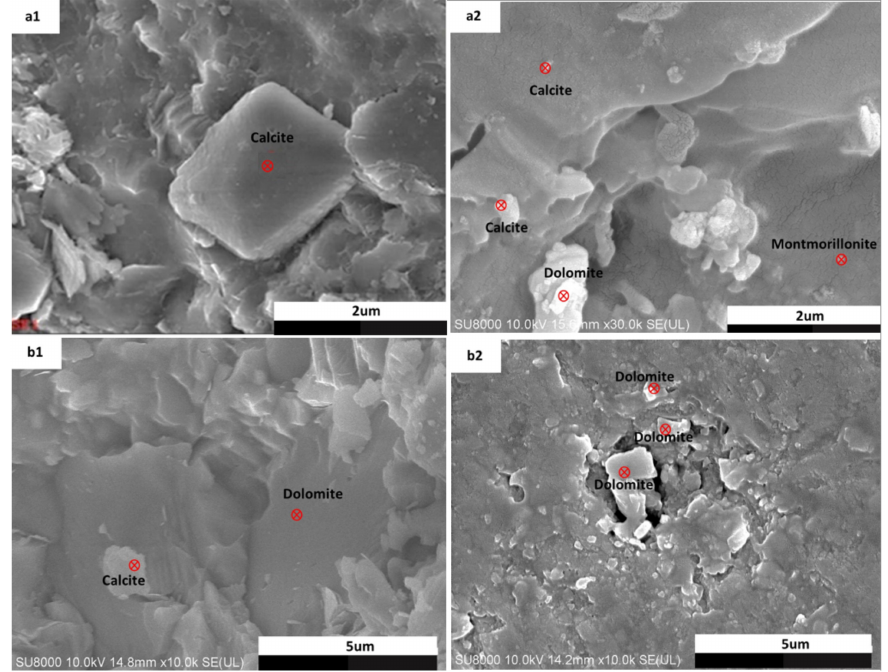
Figure 8. Scanning electron photomicrographs of rock samples: ( a1 ) Case 4 before experiment; ( a2 ) Case 4 after experiment; ( b1 ) Case 6 before experiment; ( b2 ) Case 6 after experiment.